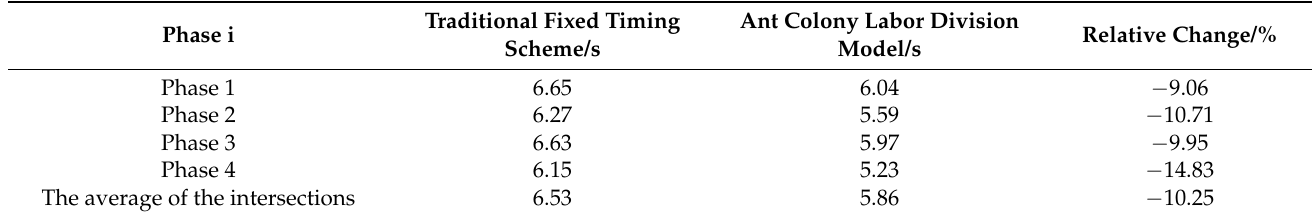
Table 1. Comparison of the average delay time of vehicles at intersections.